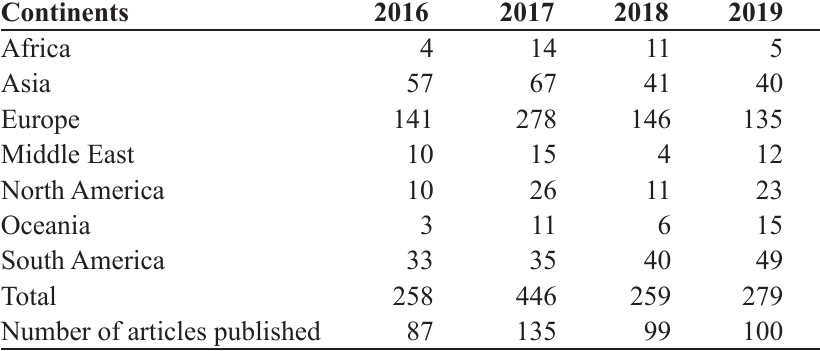
Table 4. Articles published within EJT in which at least one author is affiliated to an African institution.